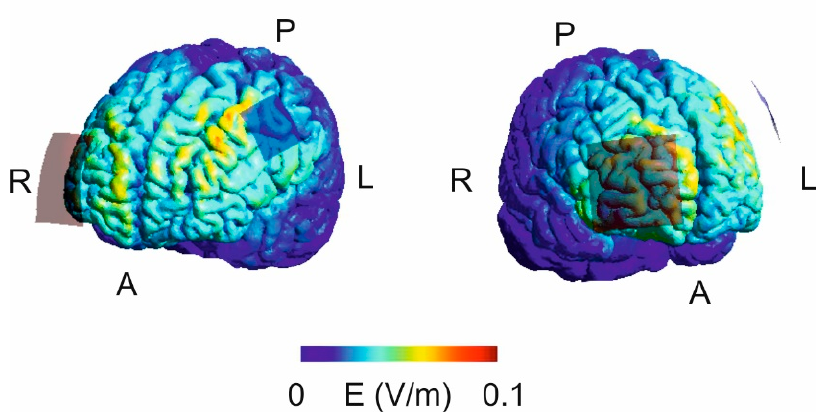
Figure 4. Visualization of the electrical field strength by means of SimNIBS and the included “Ernie” magnetic resonance imaging (MRI) data set. The analysis suggests a widespread stimulation effect with the strongest electrical field anterior to the active electrode (A = anterior; P = posterior; L = left; R = right).